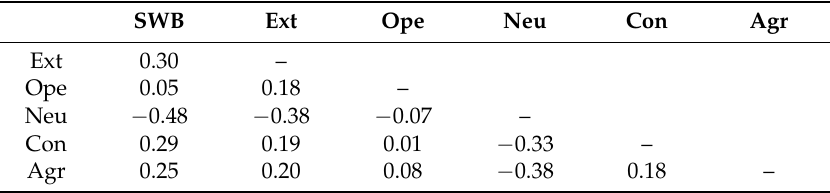
Table A4. Correlations between variables for the observed scores ( n = 21,122).